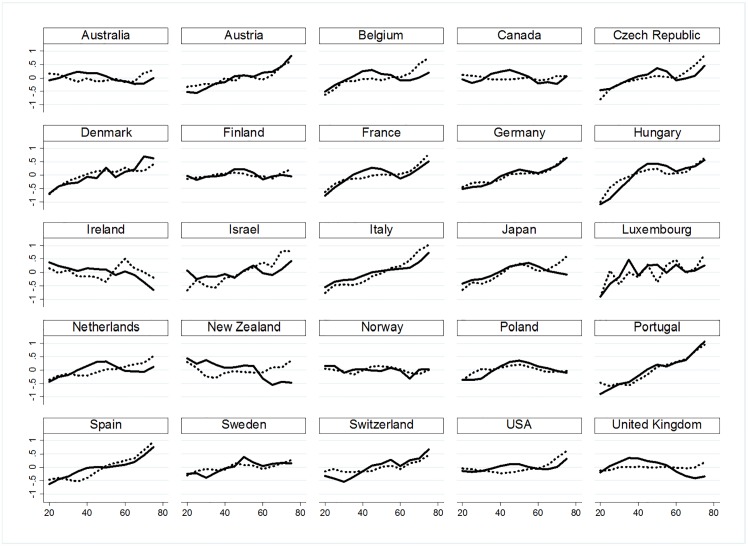
Transformation of the age profile of logged suicide rate in 1985 (dashed line) and 2005 (solid line).